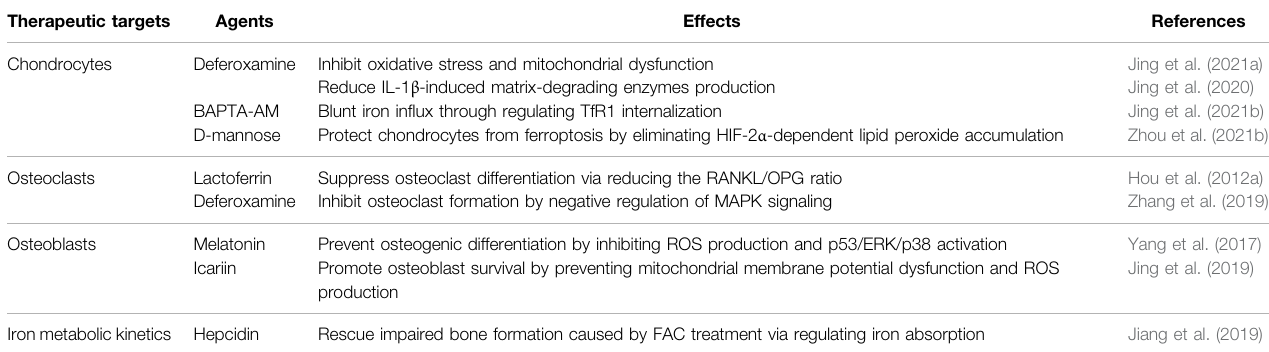
TABLE 2 | Potential clinical interventions targeting iron overload for the treatment of